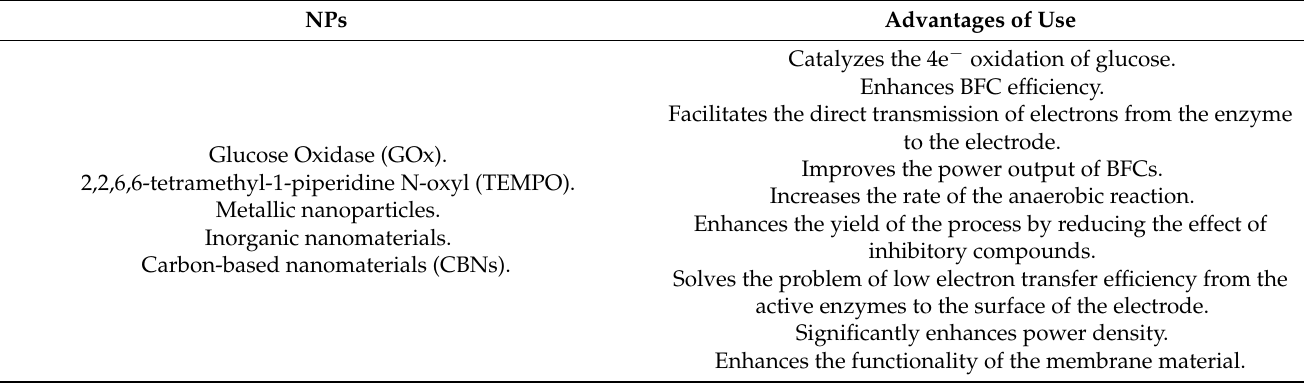
Table 5. Summary of biofuel cells